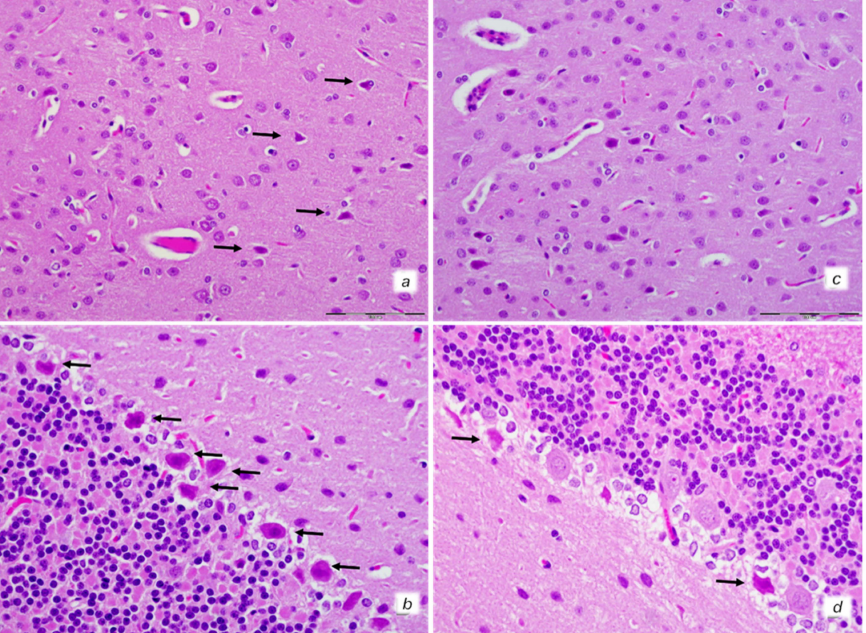
Figure 8. Neuropathological features of cerebral and celebellar cortex. Isoprenaline 75 mg/kg at 30 min after challenge. Control rats ( a , b ). ( a ) Some karyopyknotic cells in cerebral cortex (black arrows). ( b ) Moderate karyopyknosis and degeneration of Purkinje cells of the cerebellar cortex. BPC 157-treated rats ( c , d ). ( c ) No karyopyknotic cells in cerebral cortex. ( d ) Only a few karyopyknotic and degenerated Purkinje cells of the cerebellar cortex were found. (HE; magnification 400 × ; scale bar 50 µ m).